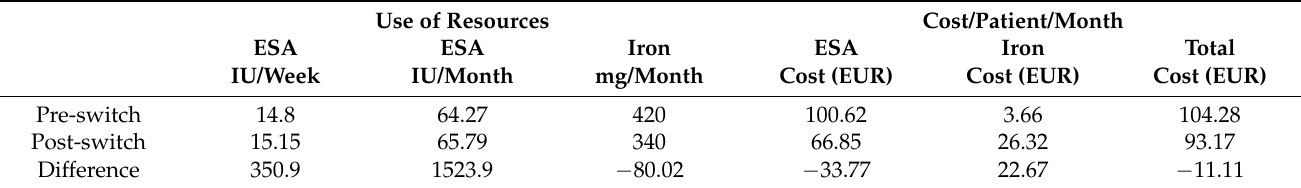
Table 3. Economic analysis over the 12-month study period ( n =